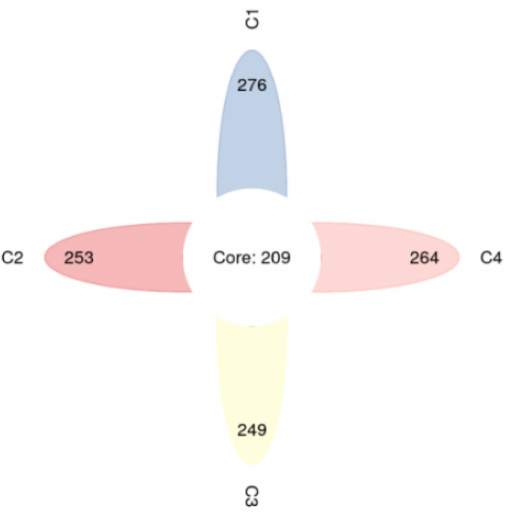
Figure 6. Venn diagram of the operational taxonomic units for microorganisms growing on the four substrate types. C1, volcanic stone; C2, nanorods; C3, ceramic pellets; C4, ceramic